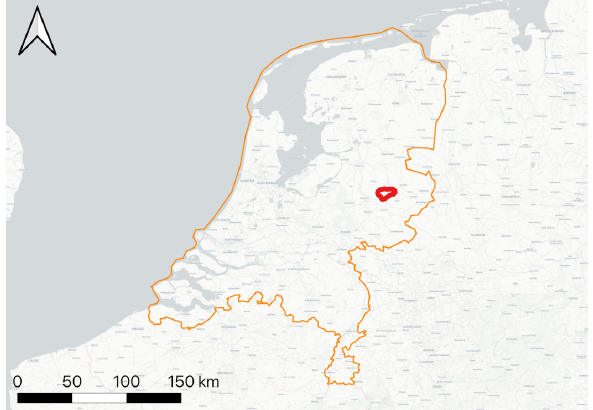
Figure 1. Rijssen-Holten, thick red line, location in the